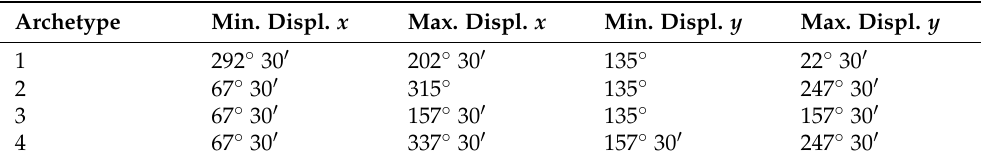
Table 7. Summary of the angles of incidence that produce the maximum and minimum roof displace- ment on the archetypes in each direction.